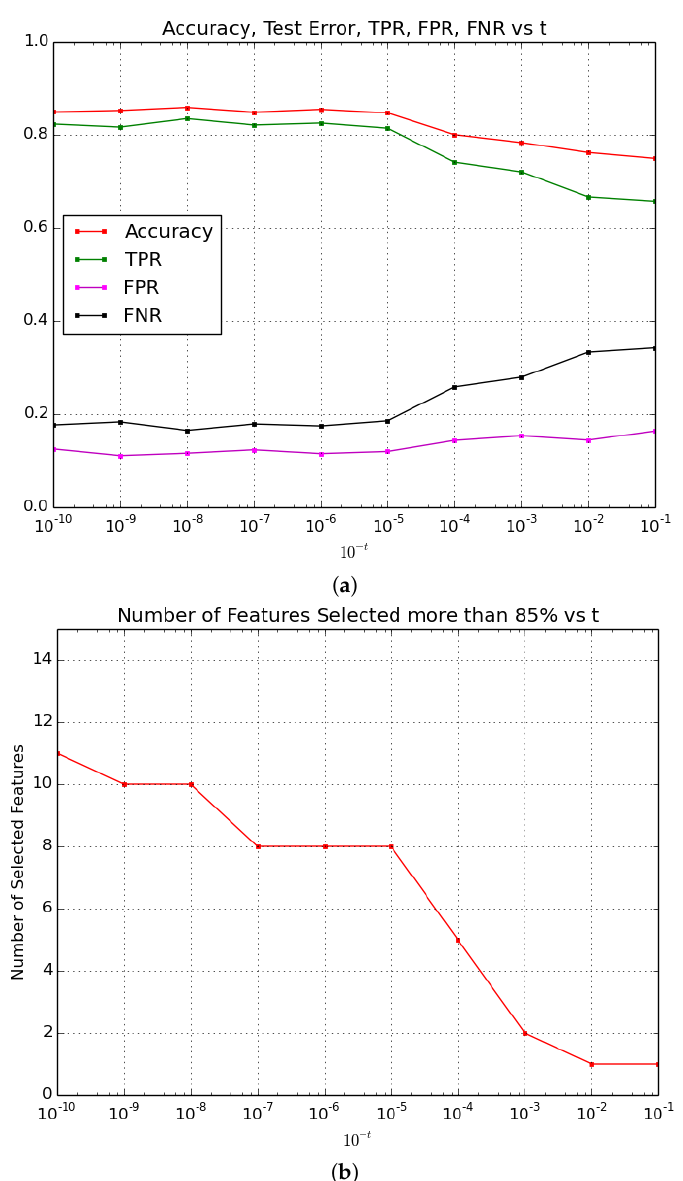
Figure 3. Elastic Net based on Tikhonov Regularization performance indicators ( a ) and number of features selected more than 85% of times ( b ) for different values of t . 10 − t is the parameter controlling the interval where τ ranges, as τ ∈ [ τ min = τ max · 10 − t , τ max · 10 − t + 1 ] . The bigger is t , the smaller are the values assumed by τ , the less sparse is the selected